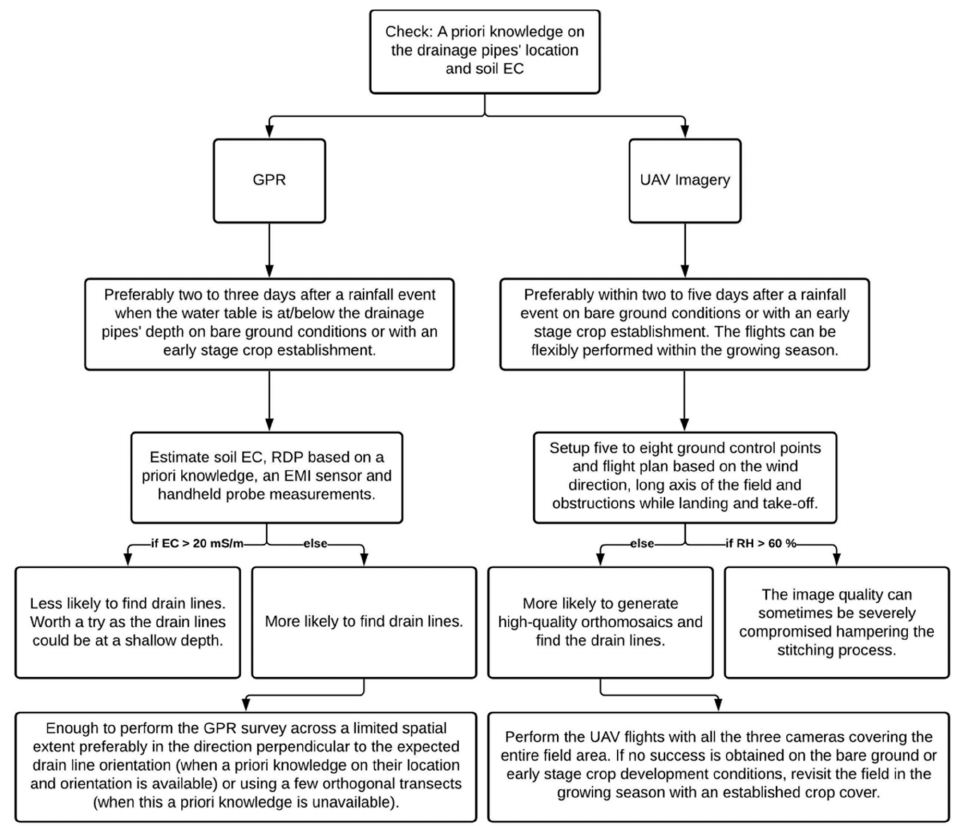
Figure 16. The decision support flowchart diagram providing guidelines for planning the subsurface drainage mapping surveys with GPR and UAV